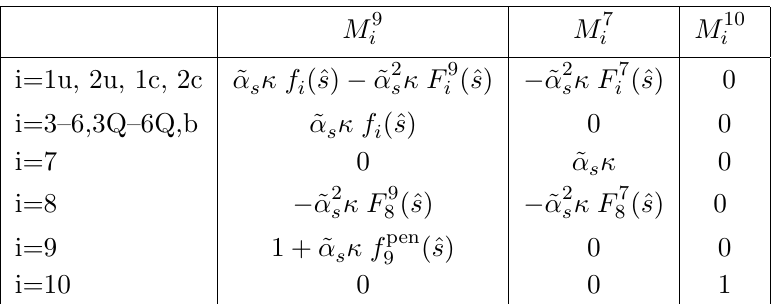
discussed in eq. i